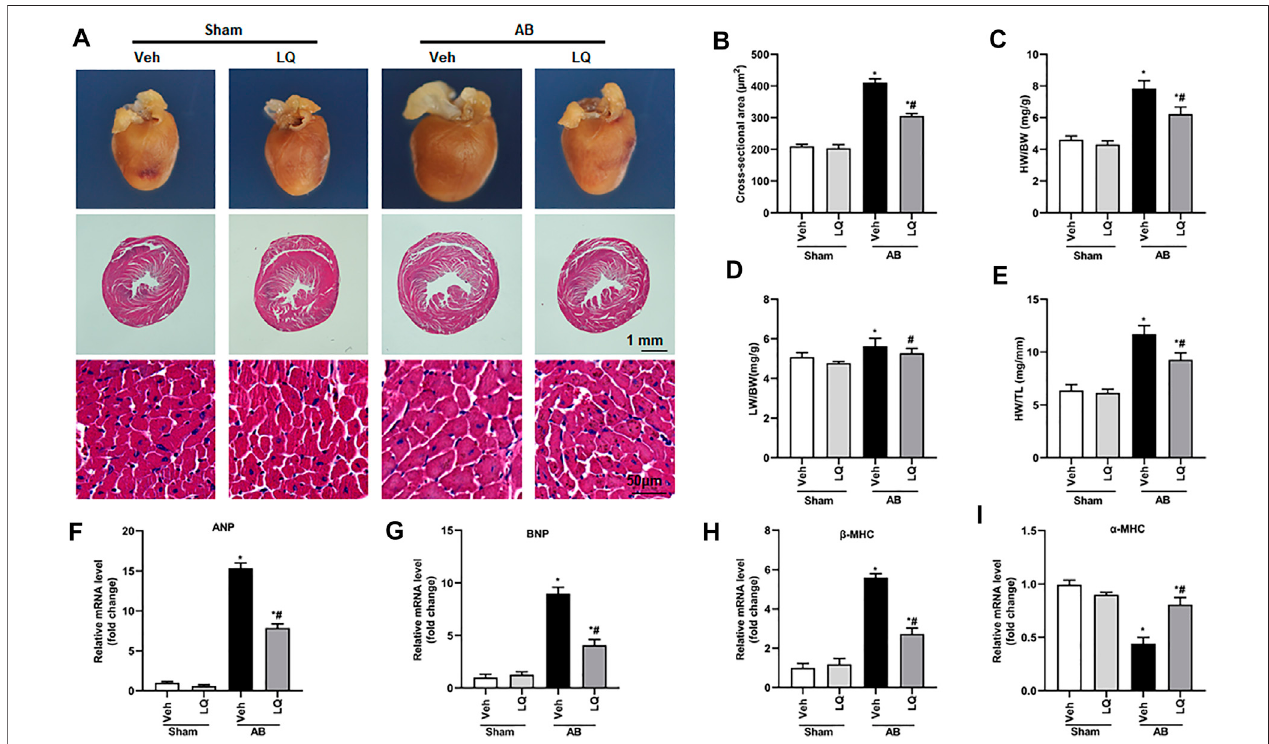
FIGURE 2 | Liquiritin attenuates cardiac hypertrophy in vivo . (A) Representative gross heart and H&E images. (B) Statistical quanti fi cation of cross-sectional areas determinedbyH&Estaining( n =6). (C – E) Heartweight/bodyweight(HW/BW),lungweight/bodyweight(LW/BW),andheartweight/tibialength(HW/TL)measurements ( n = 6). Relative mRNA levels of (F) ANP, (G) BNP, (H) β -MHC, and (I) α -MCH ( n = 6). mRNA expression of target genes was normalized to GAPDH. Data are presented asthemean±SEM.One-wayANOVAwasperformedtoexaminestatisticaldifferencesamongdifferentgroups.* p < 0.05vs.Sham+Veh;# p <